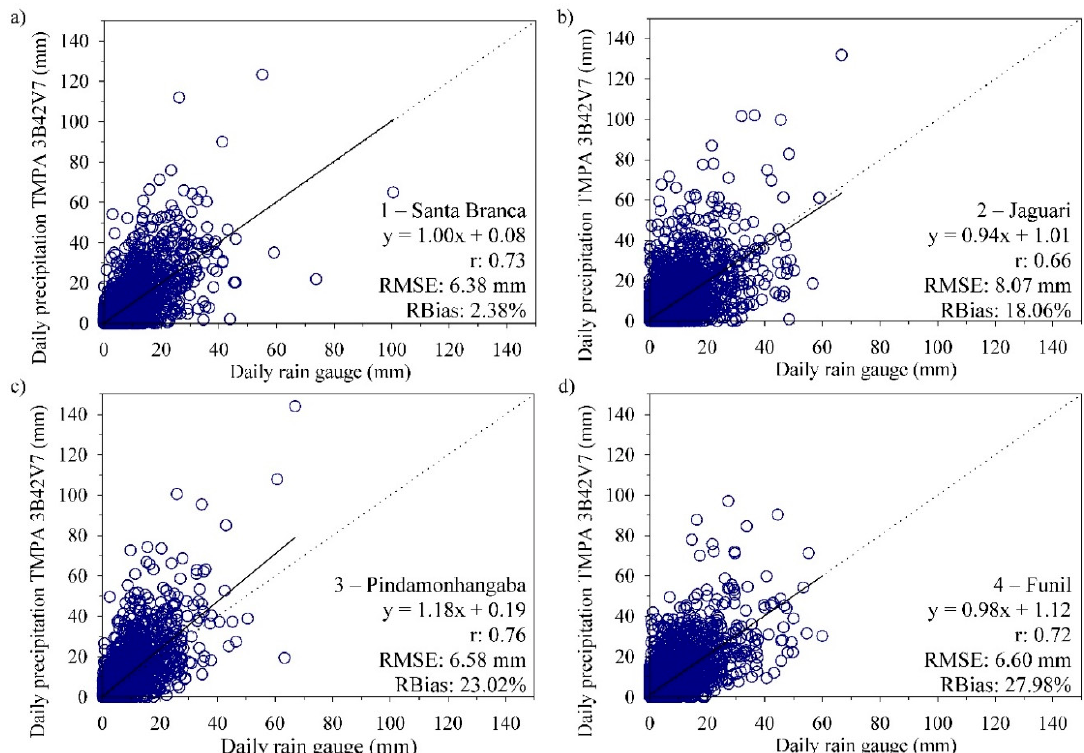
Figure 5. Scatterplot between daily TMPA 3B42V7 and rain gauge data for watersheds ( a ) 1, ( b ) 2, ( c ) 3, and ( d ) 4.